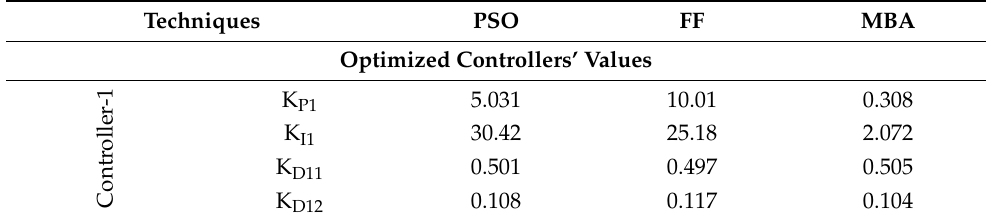
Table 3. PI − (1 + DD) controller’s parameters for the selected scenario (Scenario